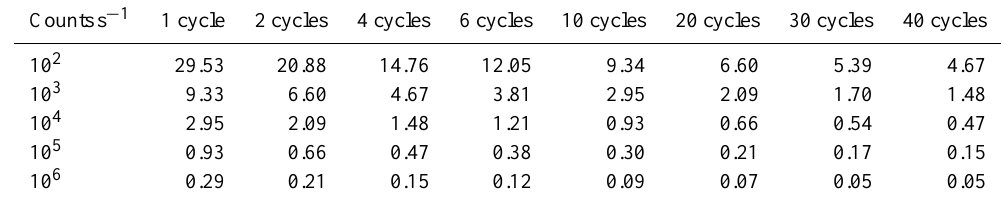
Table 1. Uncertainty (1 σ) in percent of the measured signal due to photon noise for different levels of the signal and number of cycles. Countss − 1 1 cycle 2 cycles 4